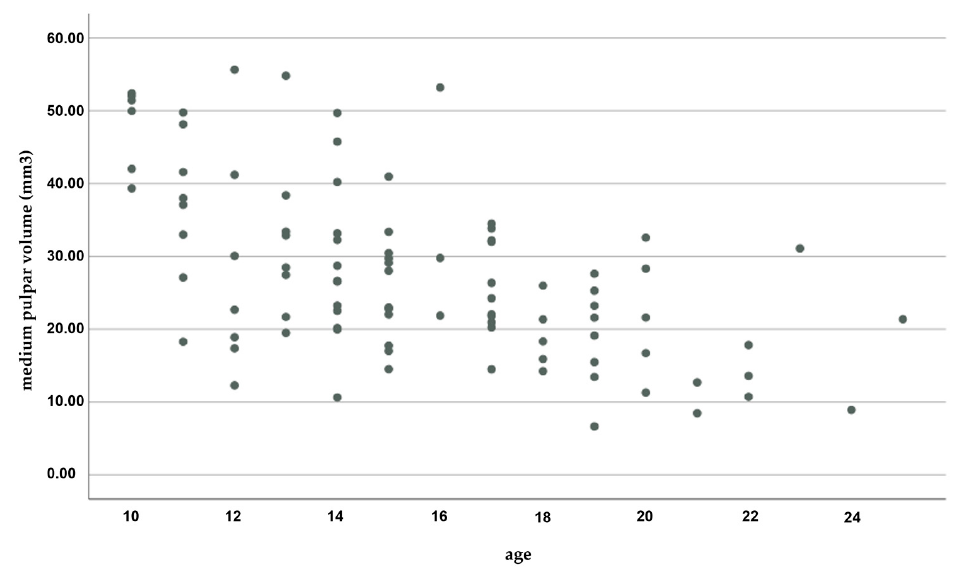
Figure 5 . Relationship between age and medium pulpal volume